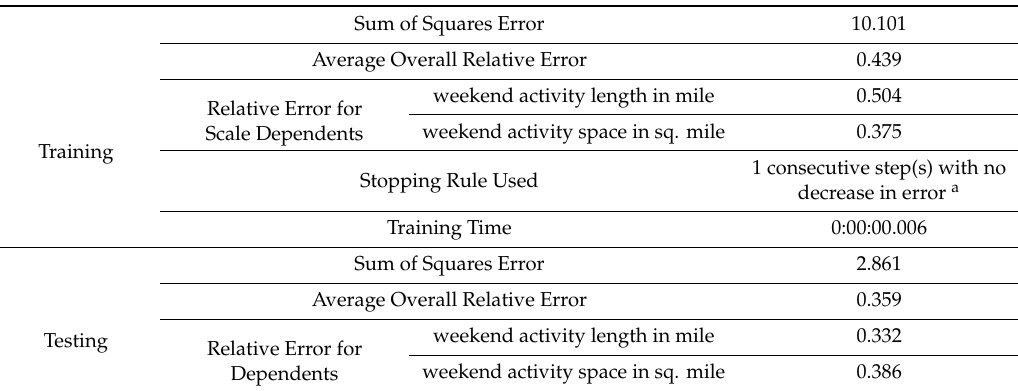
Table 16. Model Summary.